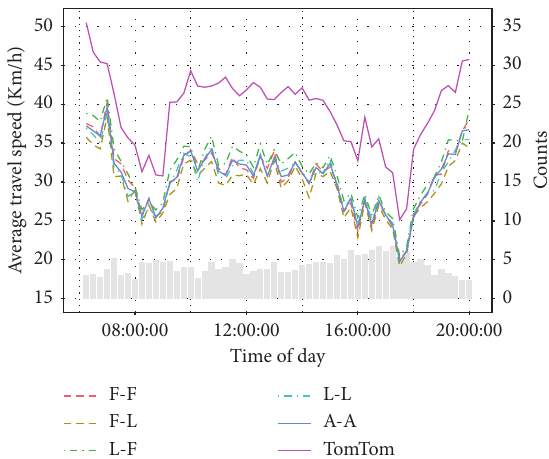
Figure 16: The comparison of five BTaverage speeds and TomTom average speed of link 748-48.